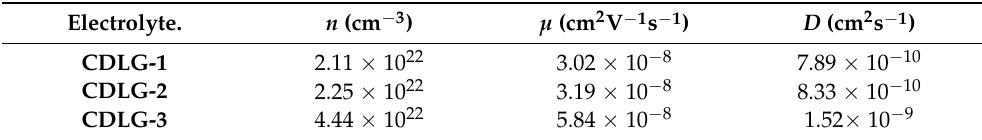
Table 4. Ion transport parameters using FTIR